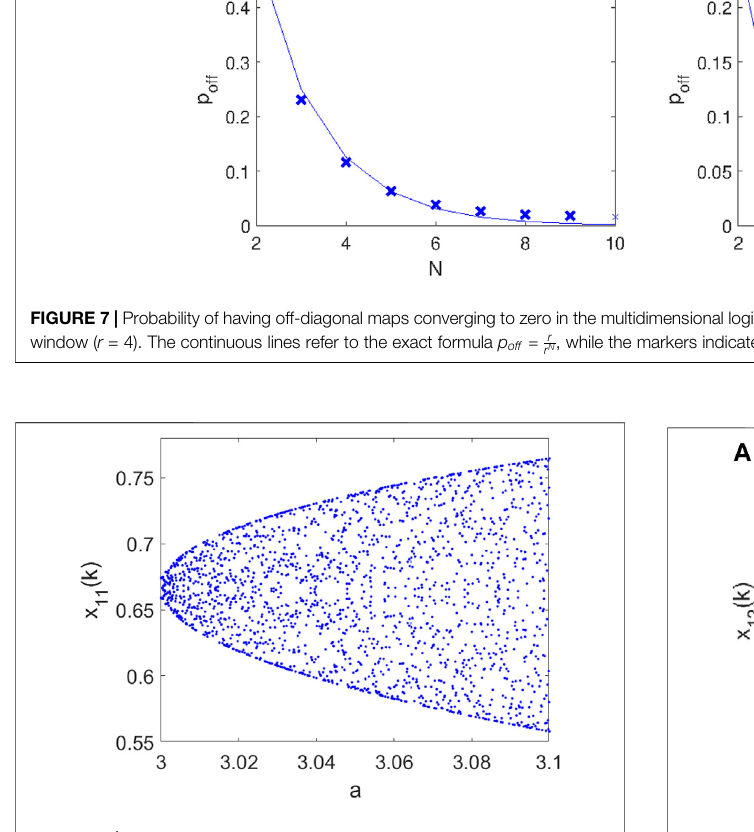
FIGURE 8 | Bifurcation diagram of the multidimensional logistic map in Eq. 16 with respect to a , for N = 4, in the period-2 window. Points represent the steady state for 100 different realizations for each value of a .